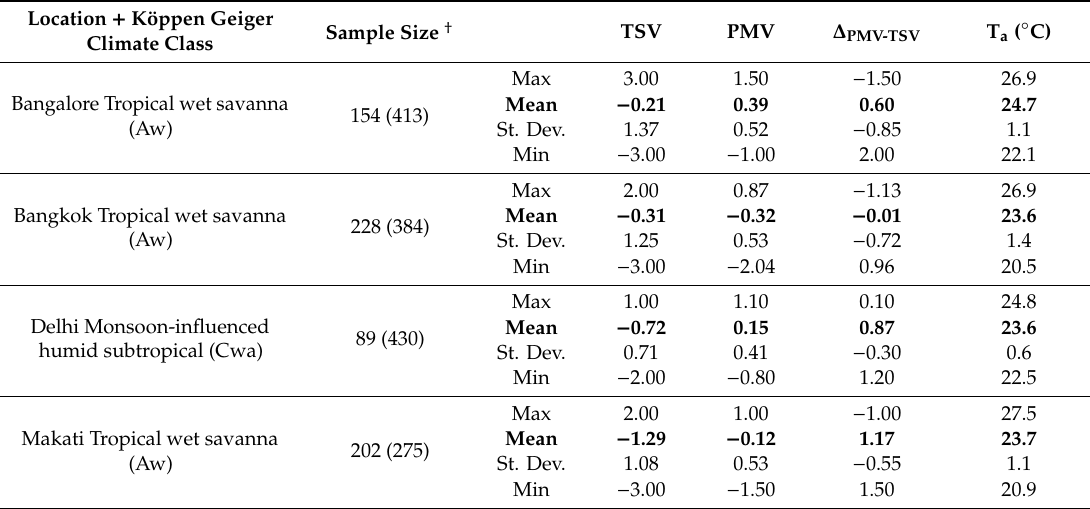
Table 2. Descriptive statistics for the four extant thermal comfort studies in the Global South using the ASHRAE Global Thermal Comfort Database